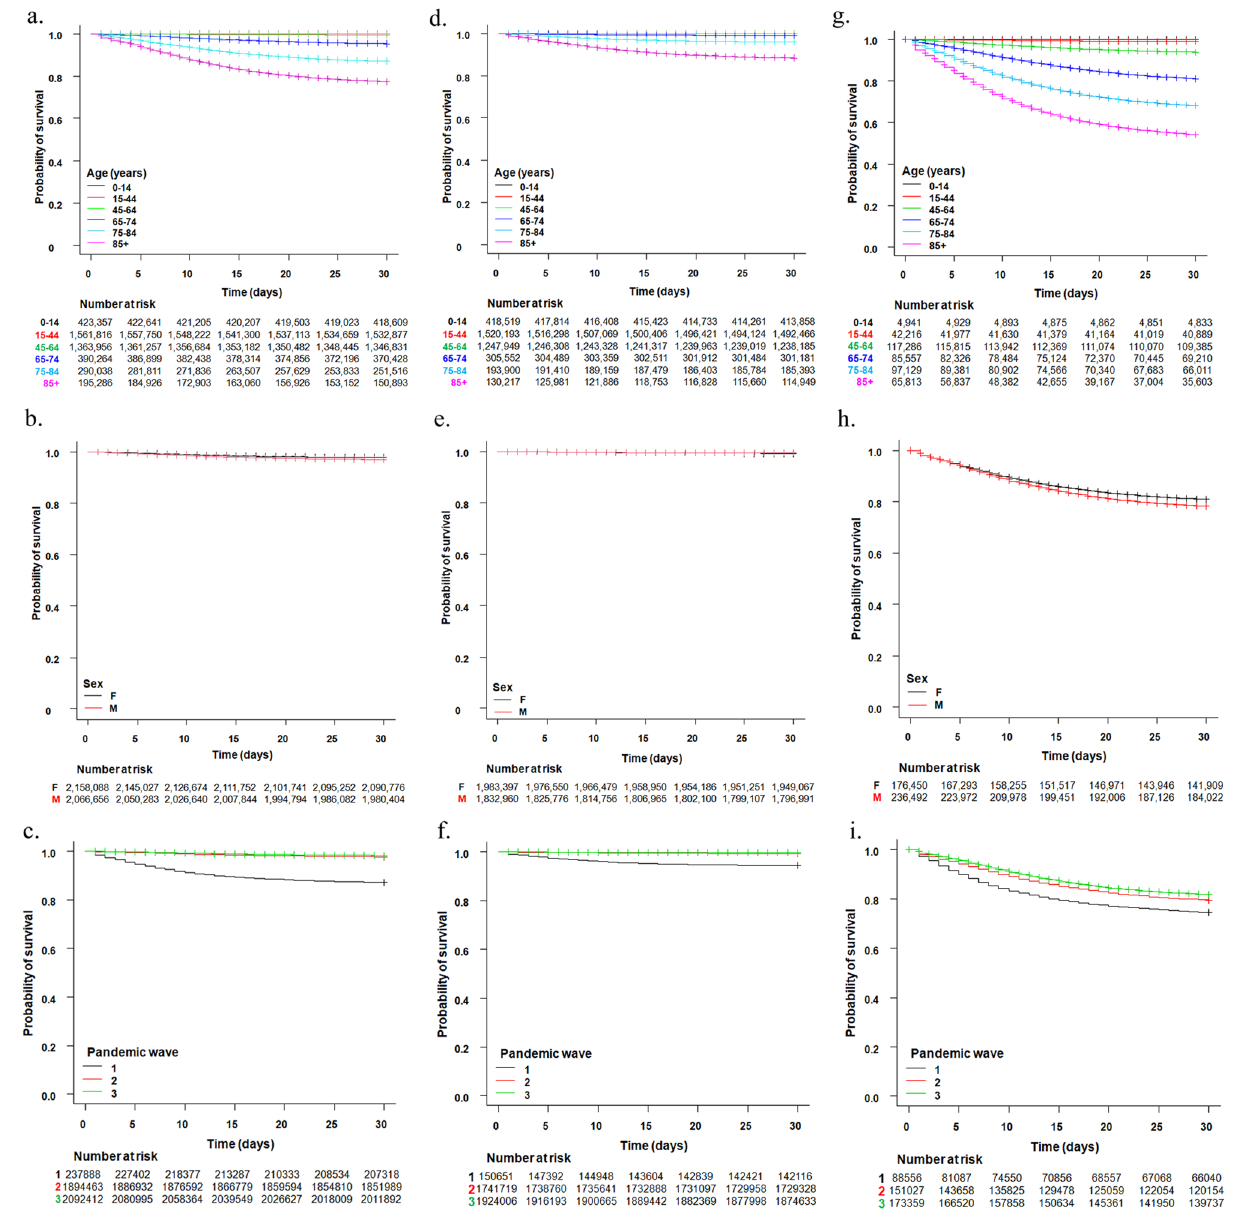
Figure 1. Kaplan–Meier survival curves for the entire Italian series of SARS-CoV-2-positive persons (panels A – C ), for non-hospitalized persons (panels D – F ), and for hospitalized COVID-19 patients (panels G – I ) in the Italian national COVID-19 series, by age group, sex, and pandemic wave (1 = before June 30, 2020, 2 = from July 1 to December 31, 2020, and 3 = after December 31, 2020). Crosses denote censored samples. Numbers of patients at risk for each group, at each time point, are reported under each plot. Log-rank test P < 2 × 10 –16 , except for panel ( E ) for which P = 1.2 × 10 –11